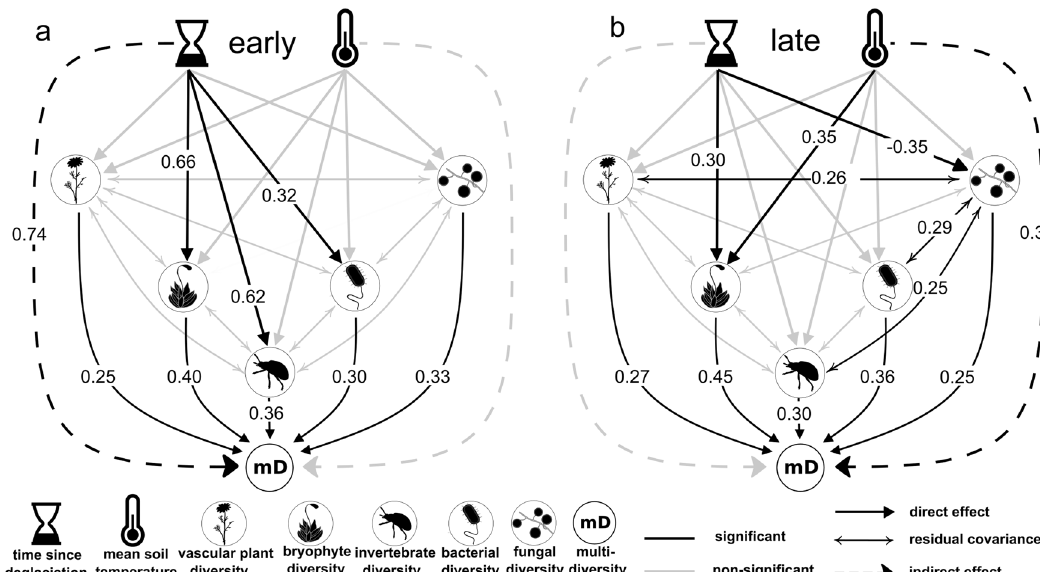
Fig. 3 Path analysis regarding the effects of stochastic and deterministic drivers on the multidiverse community for the early and late successional stages. Time since deglaciation and mean growth-season soil temperature act as exogenous variables with directed effects on the diversities of vascular plants, bryophytes, invertebrates, and soil-inhabiting fungi and bacteria. Indirect effects of exogenous variables on multidiversity were calculated by mediation analysis through the direct effects of the organismal groups on multidiversity. Biotic interactions are modeled as covariances between organismal groups. Numbers represent standardized path coef fi cients and are given for signi fi cant paths only. The path model was calculated for ( a ) the early and ( b ) the late successional stage separately. Silhouette images were obtained from PhyloPic (http://phylopic.org) under a public domain license (CC0 1.0 license).